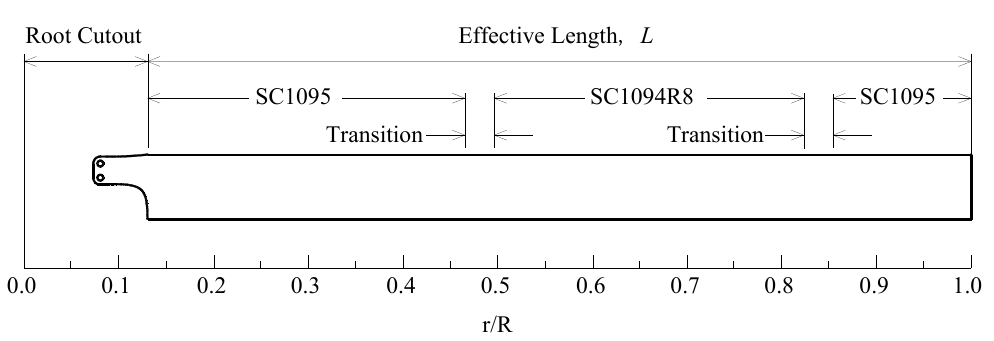
Figure 5. Layout of SC1095 and SC1094R8 airfoils on the UH-60A blade platform.